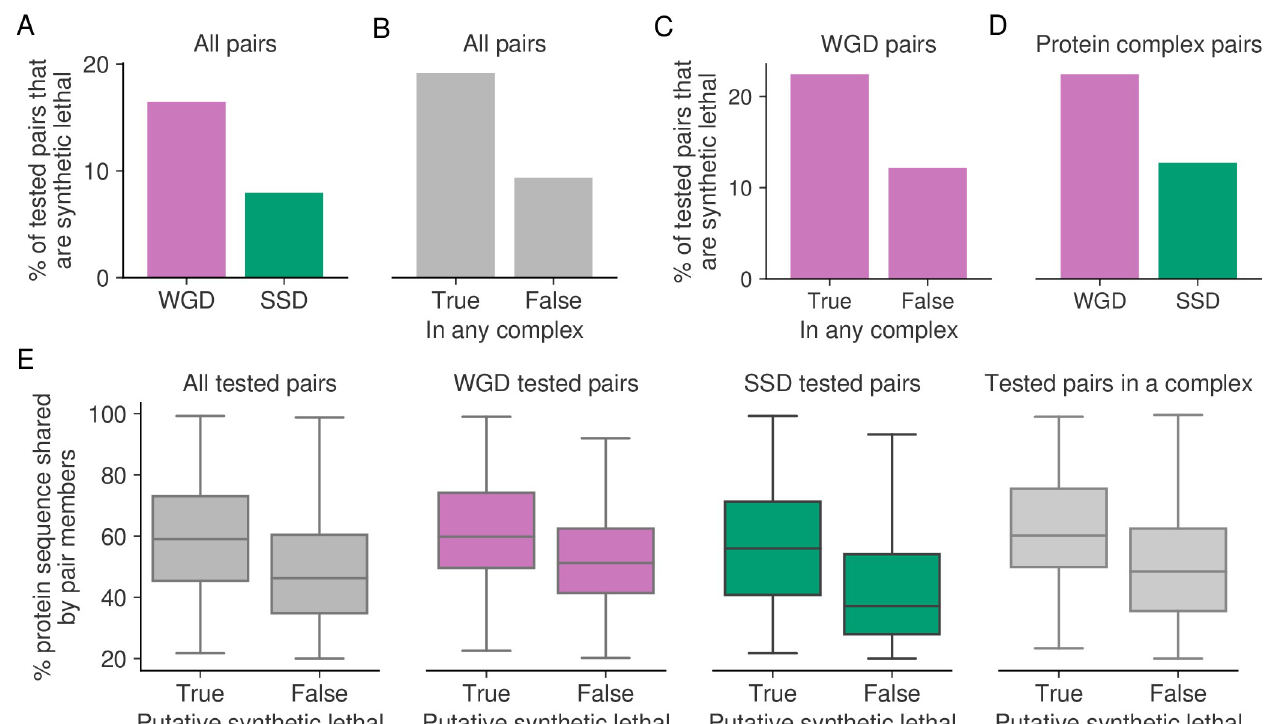
Fig 6. Duplication mode, protein complex membership and sequence similarity are predictive of synthetic lethality. (A) Bar chart showing the percentage of tested WGD and SSD pairs that are synthetic lethal. (B) Bar chart showing the percentage of synthetic lethal pairs observed among the tested pairs where at least one gene is a protein complex member versus the tested pairs where neither gene is a protein complex member. (C) Same as (B) but restricted to tested pairs that are WGDs. (D) Same as (A) but restricted to tested pairs where at least one gene is a protein complex member. (E) Boxplots showing the percent of the protein sequence that is identical in the members of a given paralog pair, for pairs that are synthetic lethal versus those that are not. The pairs used in the analysis consist of all sometimes essential paralogs and their most sequence-similar paralog, and three subsets thereof. From left to right the subsets consist of: pairs that are WGDs, pairs that are SSDs, and pairs where either gene is a protein complex member.